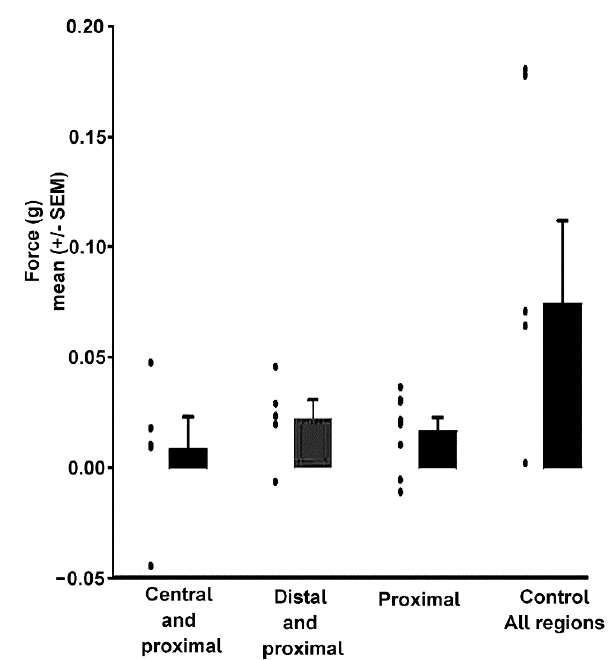
Figure 12. E ff ect of serotonin on force development for stimulation frequency at 40 Hz: This is the additional force (not total force) that was generated by the fibers during serotonin exposure. The mean ( +/ − SEM) are presented for the groups along with the values for each individual preparation as a dot. It was expected that central fibers were most a ff ected by addition of serotonin; however, this was not the case (Table 2). The force generated by the proximal fibers was subtracted from the ablated